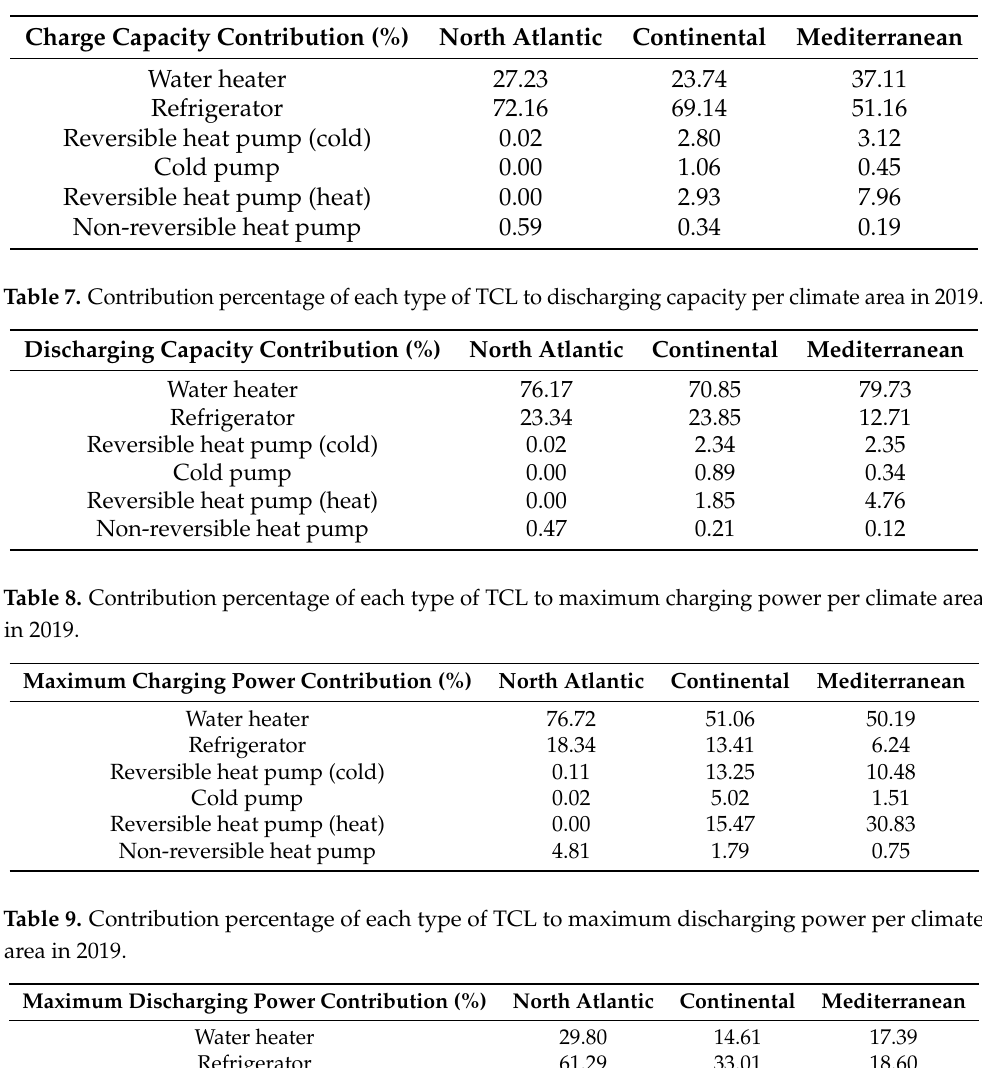
Table 6. Contribution percentage of each type of TCL to charging capacity per climate area in 2019.